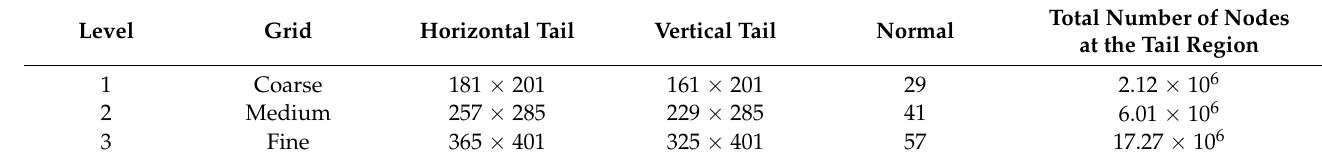
Figure 10. Coefficient of yaw moment calculated with three different grids, and comparison with the experimental results. ( a ) α = 0 ° ( b ) = −4 °.